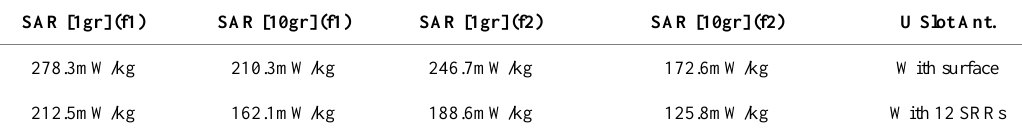
Table 5. SAR reduction using SRRs surface